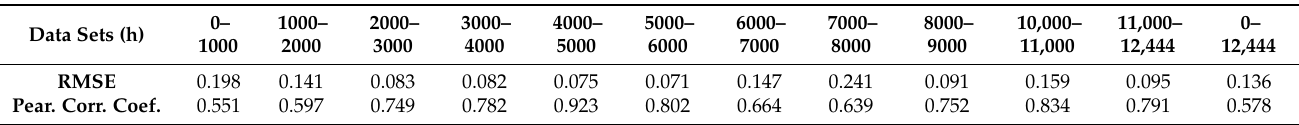
Table 2. Pearson coefficient and root mean square values obtained between the measured and simulated sea water elevation by Equation